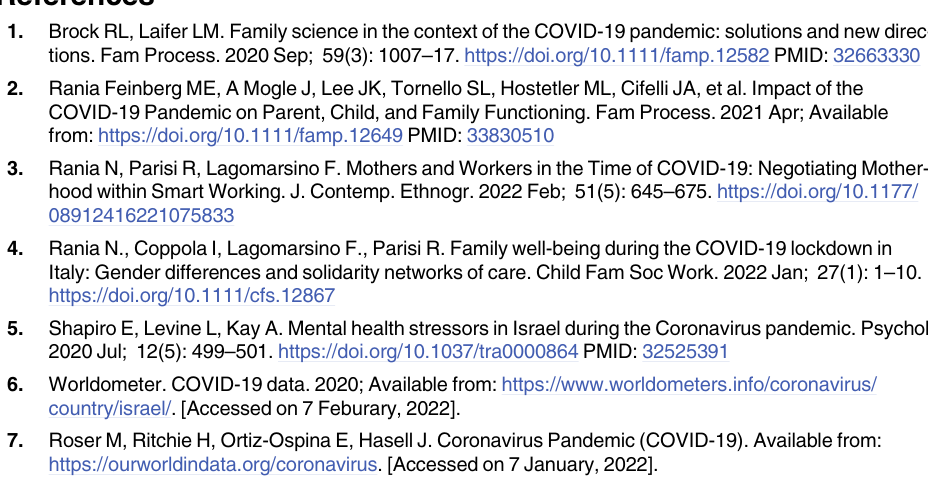
S1 Table. Correlations among COVID-19 distress, employment status, daily prevalence, and family functioning indicators. S2 Table. Means or correlations of family functioning among participants’ demographic characteristics. S1 Fig. Moderating effects of COVID-19 death on associations between parents’ remote work arrangements and family